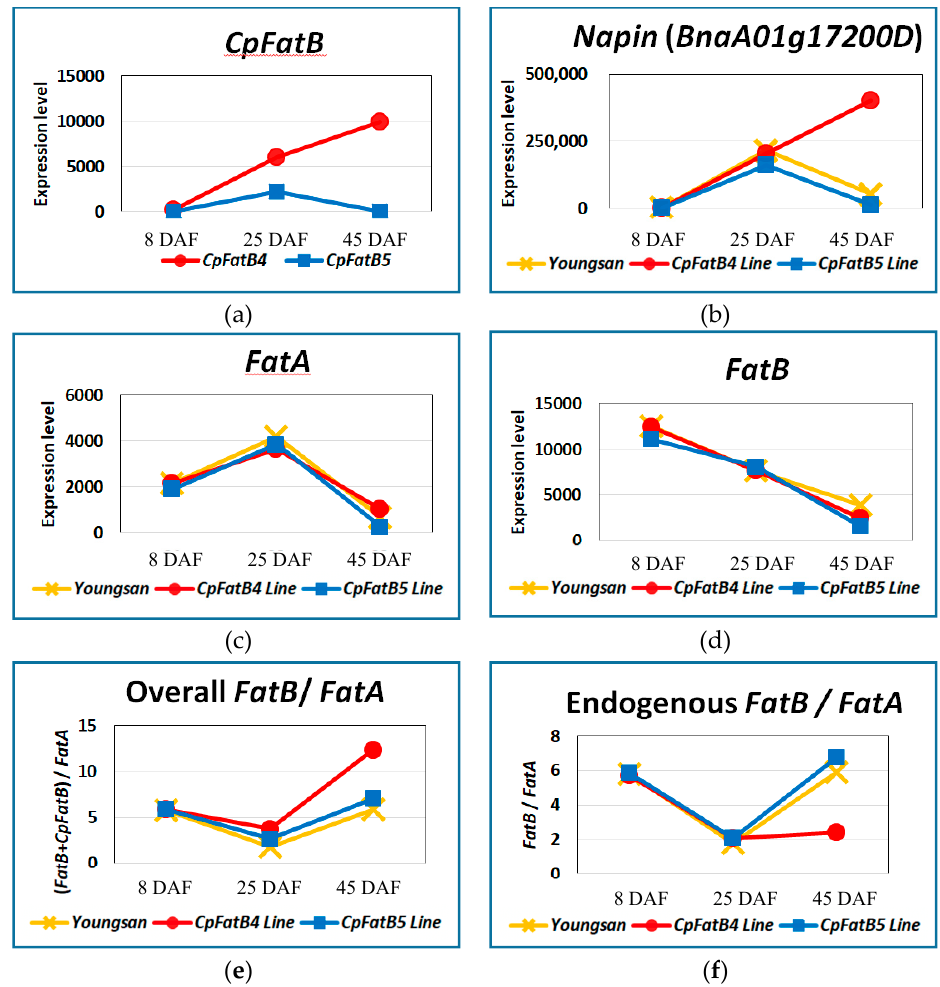
Figure 2. Thioesterase and Napin expression showed distinct patterns in CpFatB4 and CpFatB5 transgenic plants. ( a ) CpFatB expression in the corresponding transgenic plants. ( b ) Expression levels of BnaA01g17200D , a Napin gene, during pod development. ( c ) Sum of all endogenous FatA expression. ( d ) Sum of all endogenous FatB expression. ( e ) Ratio of overall expression levels of FatA and FatB , including transgenic CpFatBs . ( f ) Ratio of endogenous FatB and FatA expression in ( c ) and ( d ). Expression level was plotted using raw read numbers. CpFatB : read numbers of CpFatB4 or CpFatB5 ; CpFatB4